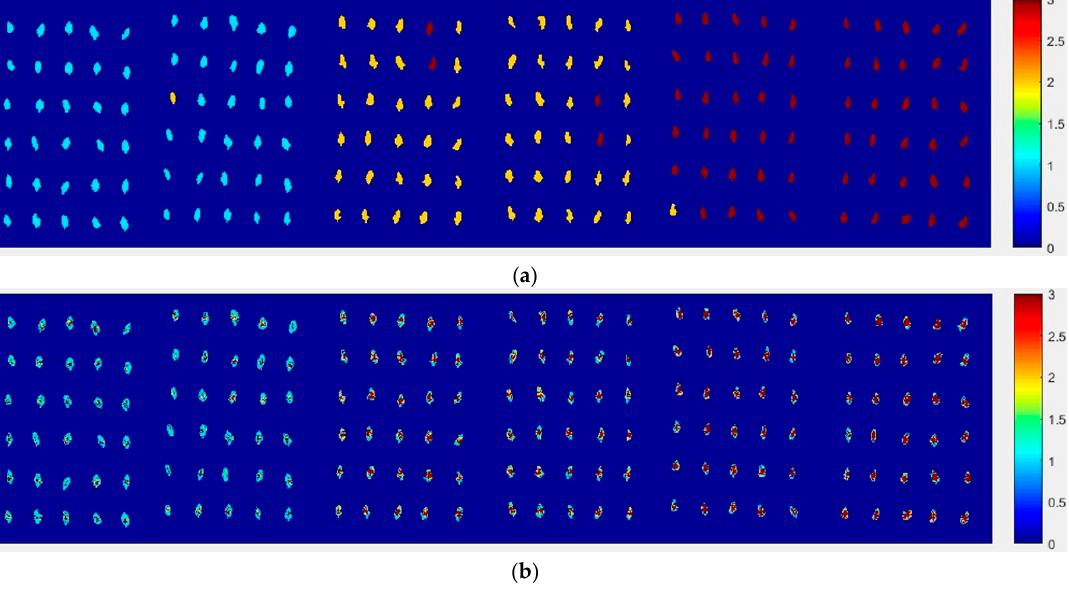
Figure 10. The visualization images ( a ) method M2M and ( b ) method M2P for Haihe78 with the SPA and PLS-DA model.